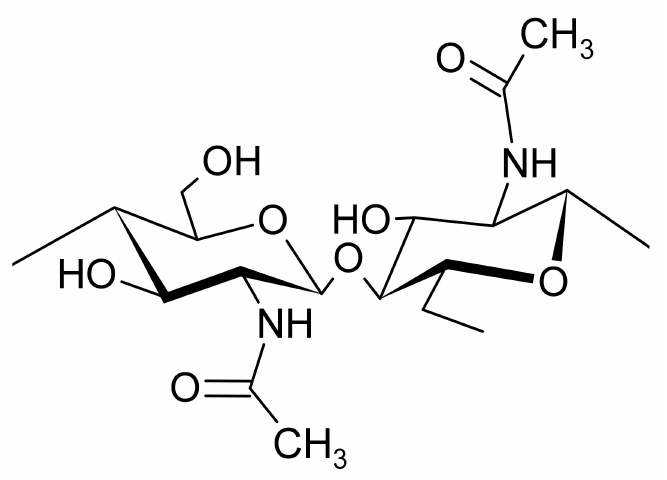
Figure 2. Chemical structure of